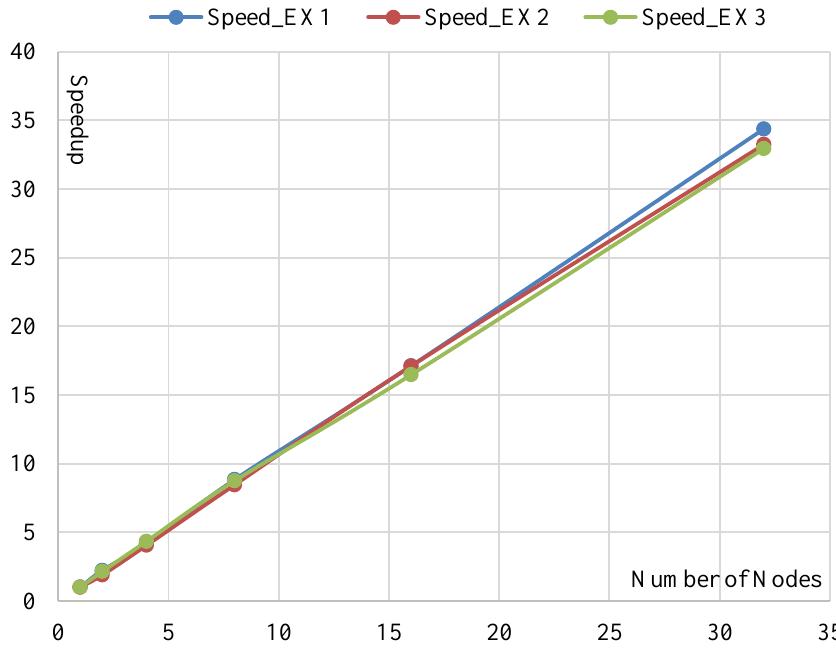
Figure 8. Speedups of DPA with different numbers of nodes in Experiments